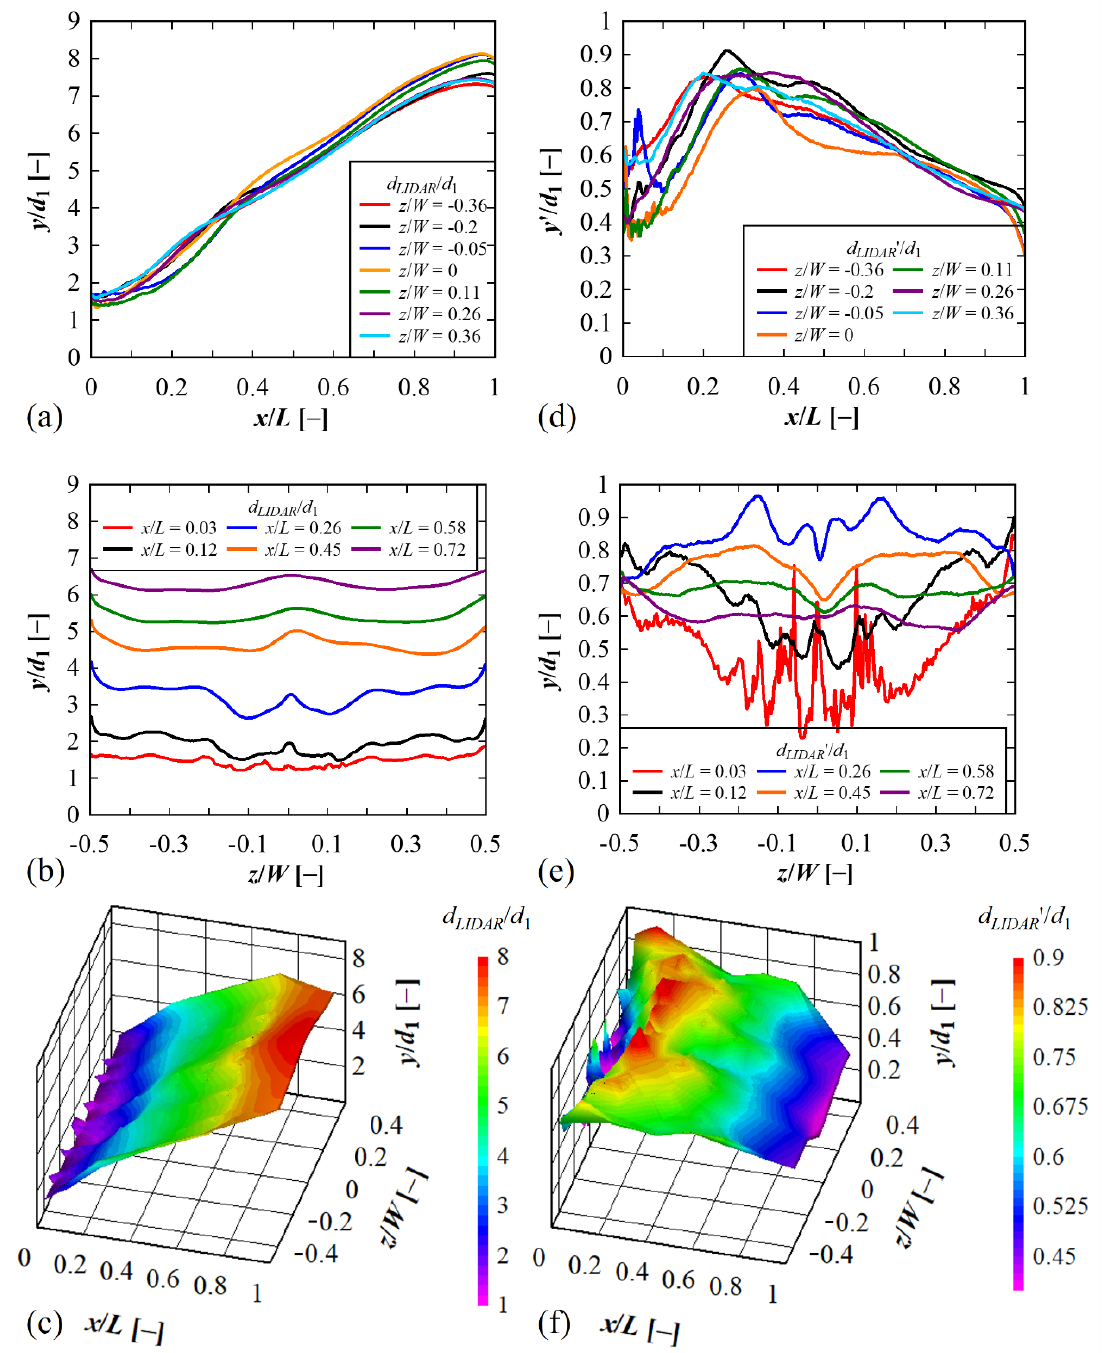
Figure 4. Dimensionless free-surface mean elevations and fluctuations for q = 0.19 m 2 /s, Fr 1 = 6.7, and Re = 1.9 × 10 5 : ( a – c ) mean elevations ( d LIDAR / d 1 ): ( a ) longitudinal; ( b ) transverse; ( c ) three-dimensional map of mean elevations; ( d – f ) fluctuations ( d LIDAR ’ / d 1 ): ( d ) longitudinal; ( e ) transverse; ( f ) three-dimensional map of free-surface fluctuations.